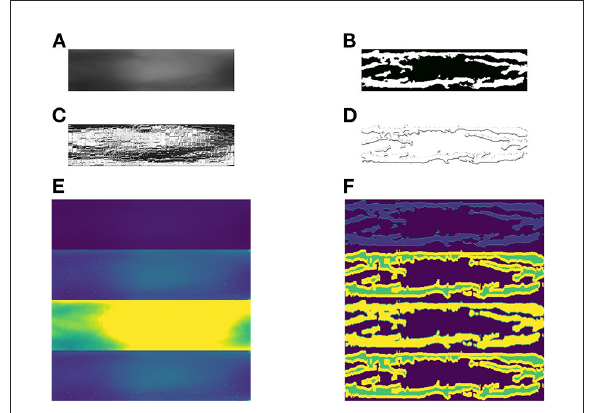
FIGURE6 Samples of 6 different feature maps. (A) 1st feature map, (B) 2nd feature map, (C) 3rd feature map, (D) 4th feature map, (E) 5th feature map, and (F) 6th feature